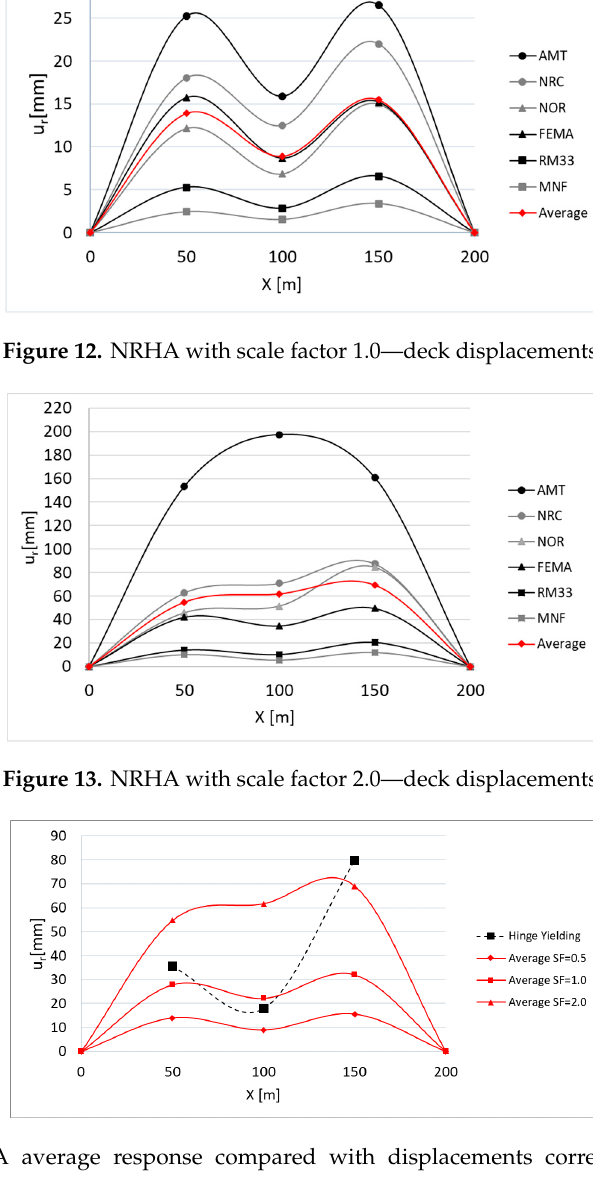
Figure 14. NRHA average response compared with displacements corresponding to plastic hinges yielding.